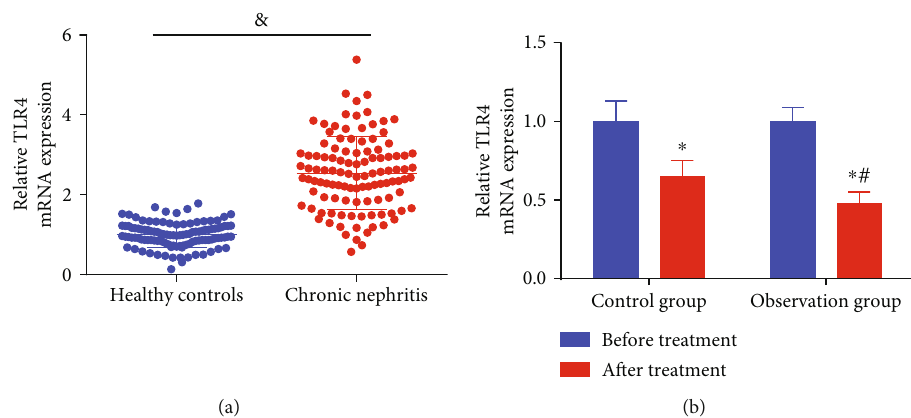
Figure 2: Valsartan in combination with tripterygium glycosides reduces TLR4 levels of chronic nephritis patients. (a) TLR4 levels in serum of healthy volunteers versus patients with nephritis were examined by RT-qPCR. (b) PCR to detect TLR4 expression in serum of patients before and after treatment in the observation and control groups was tested by RT-qPCR. & P < 0 : 05 vs. healthy controls; ∗ P < 0 : 05 vs. before treatment; # P < 0 : 05 vs. the control